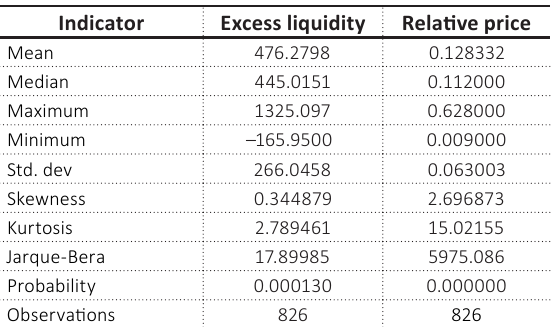
Table 1. Descriptive statistics of excess liquidity